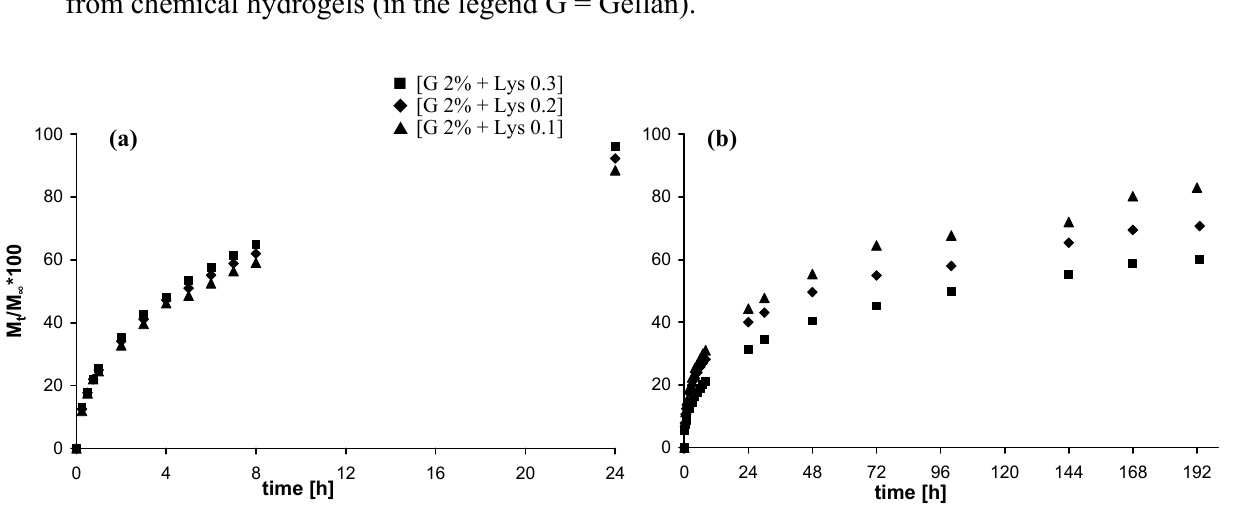
Figure 7. Release profiles (37 °C, SIF) of DexFluo 70 : (a) from physical hydrogels; (b) from chemical hydrogels (in the legend G =